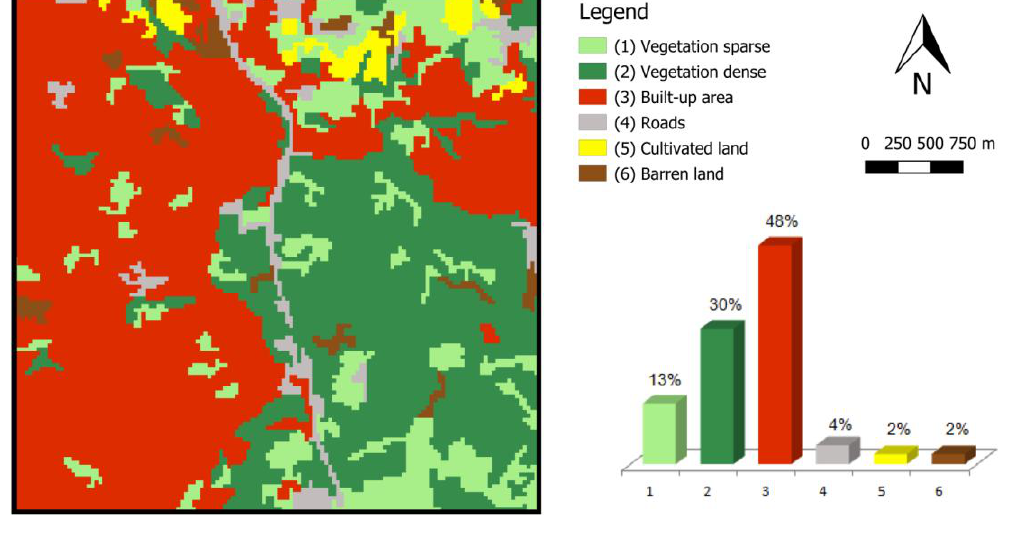
Figure 9. Landsat-8 classified image